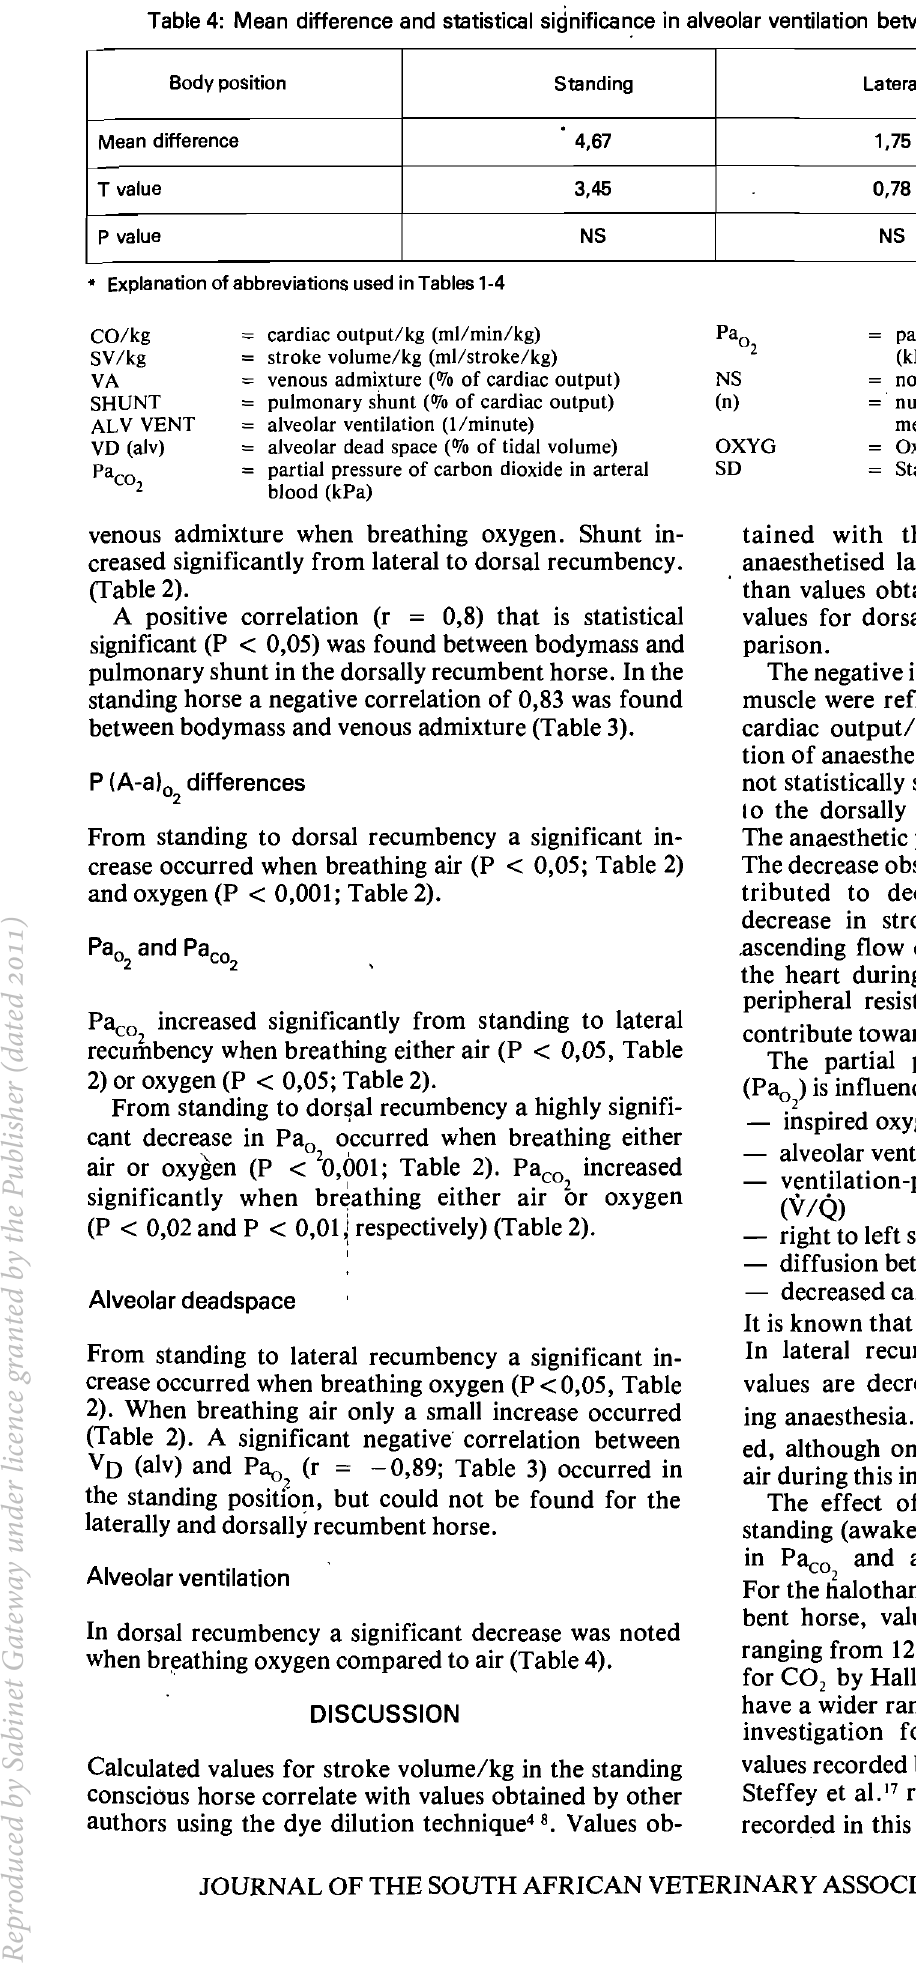
Table 4: Mean difference and statistical siclnifica~ce in alveolar ventilation between oxygen and air breathing horses Body position Standing Mean difference